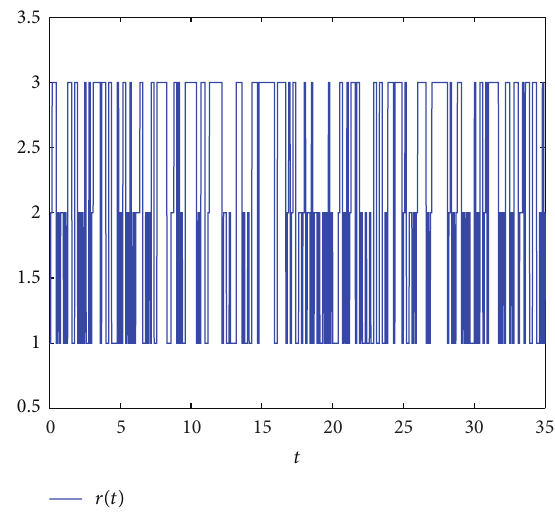
Figure 3: Markovian chain generated by probability transition matrix corresponding to the generator (50) with Δ𝑡 = 0.01, 𝛾 (0) = 2.